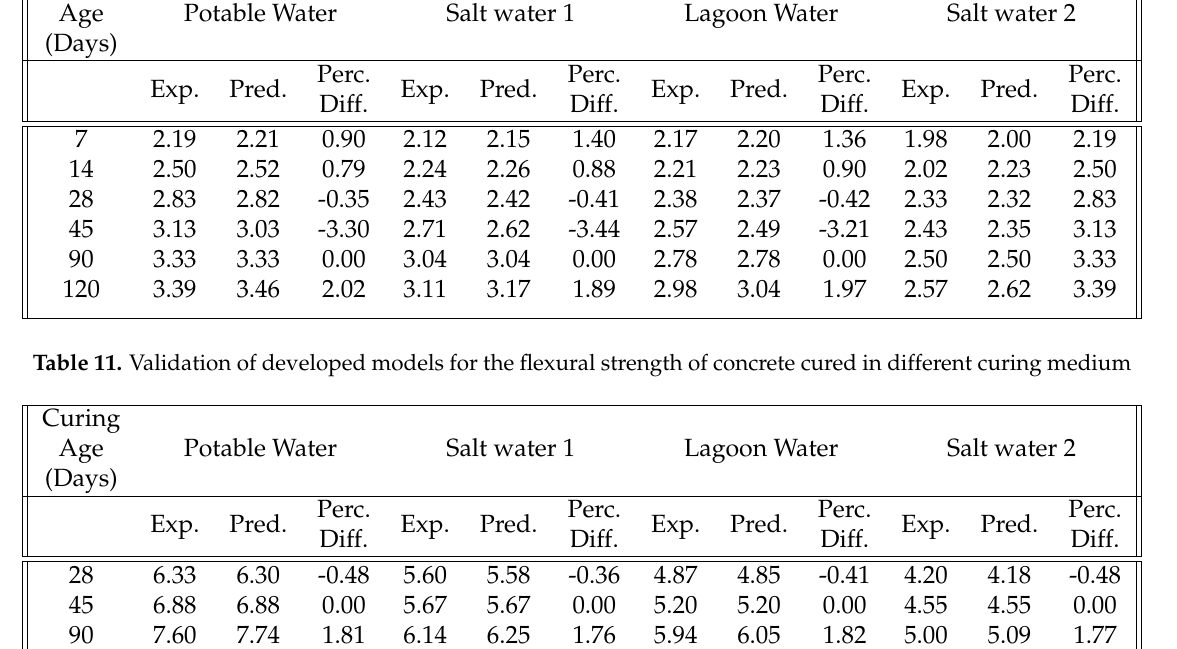
Table 10. Validation of developed models for the split tensile strength of concrete cured in different curing medium Curing Age Potable Water (Days)